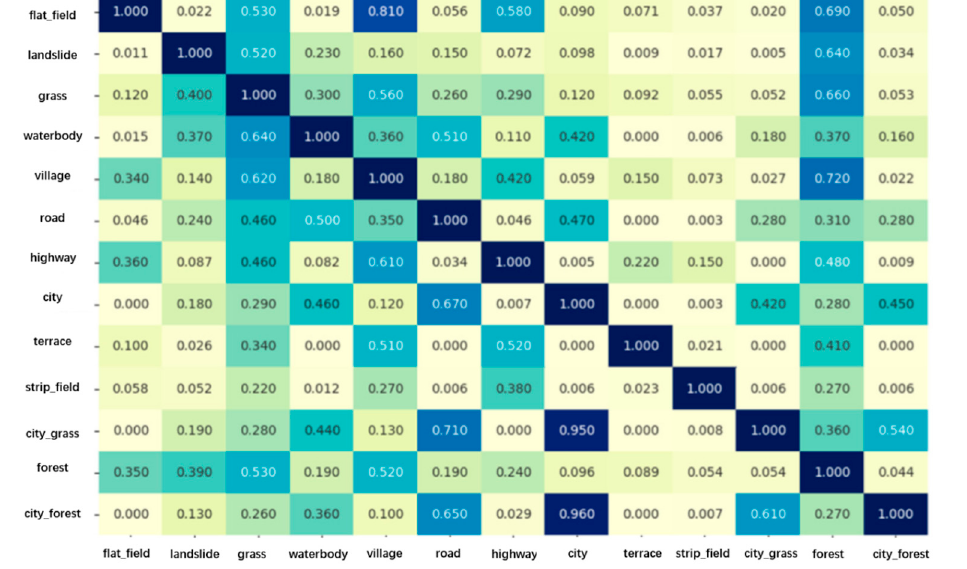
Figure 10. The co-occurrence matrix. Values in this matrix indicate the co-occurrence probabilities of various categories.